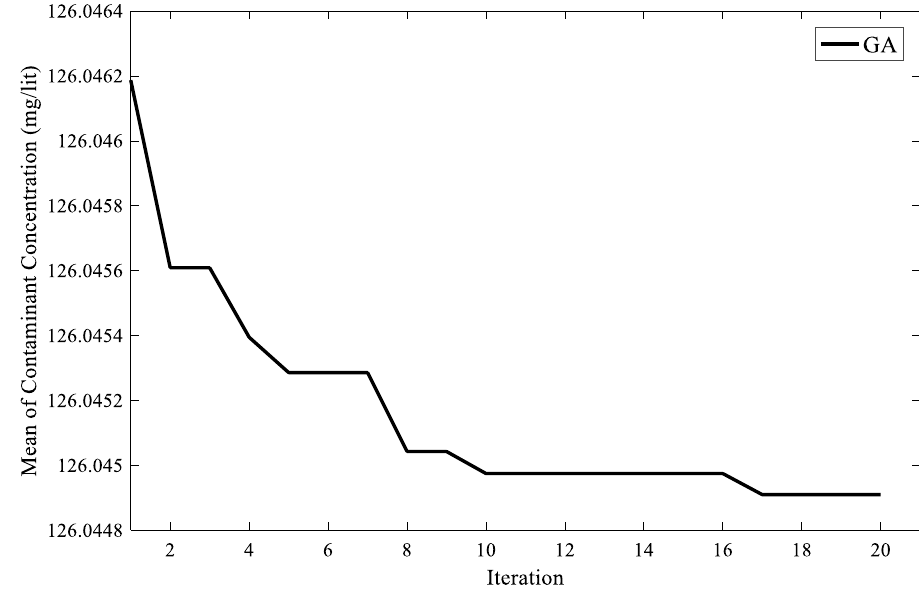
Fig. 13 The convergence trend of GA